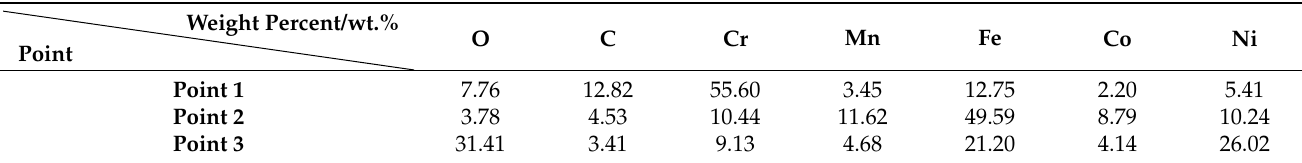
Table 5. Point analysis of elements in the worn surface of the CoCrFeNiMn HEA coating prepared at 55 A plasma arc